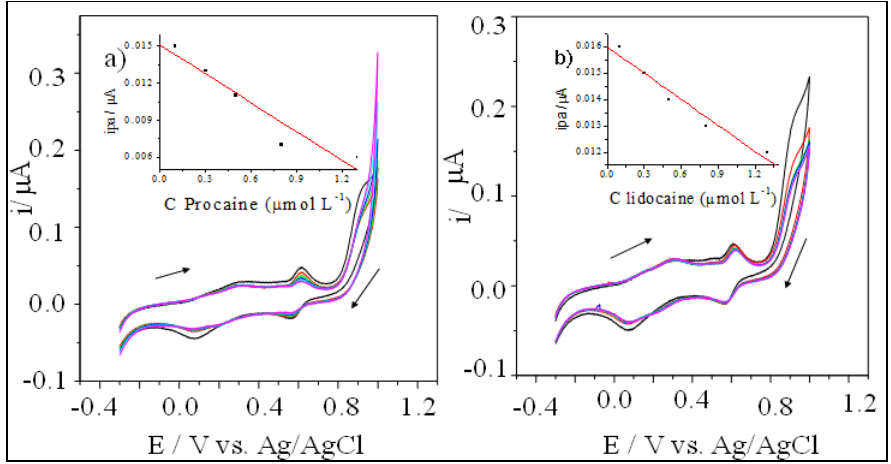
Figure 4. Influence of the concentration cocaine standard samples in the electrochemical response of the electrode modified with [UO